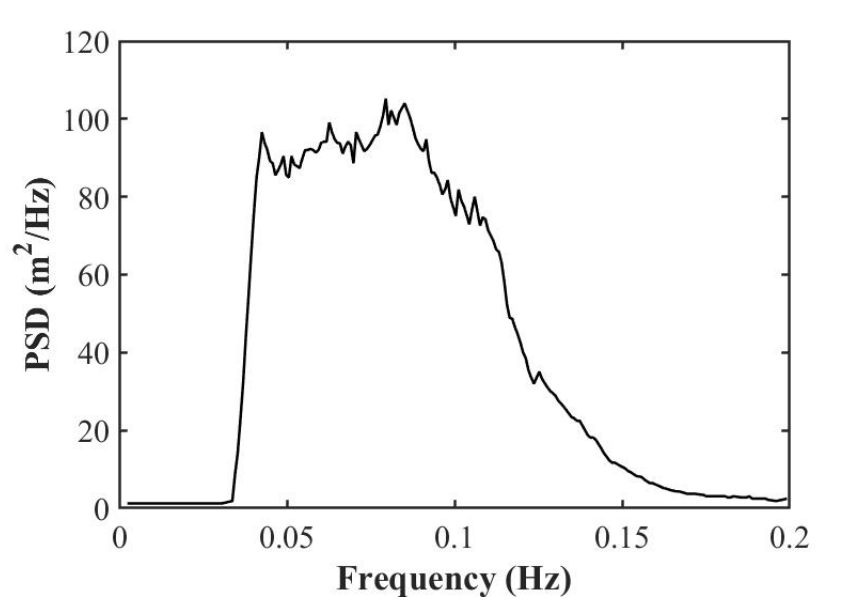
Table 3. Summary of the verifications for dynamics simulation.